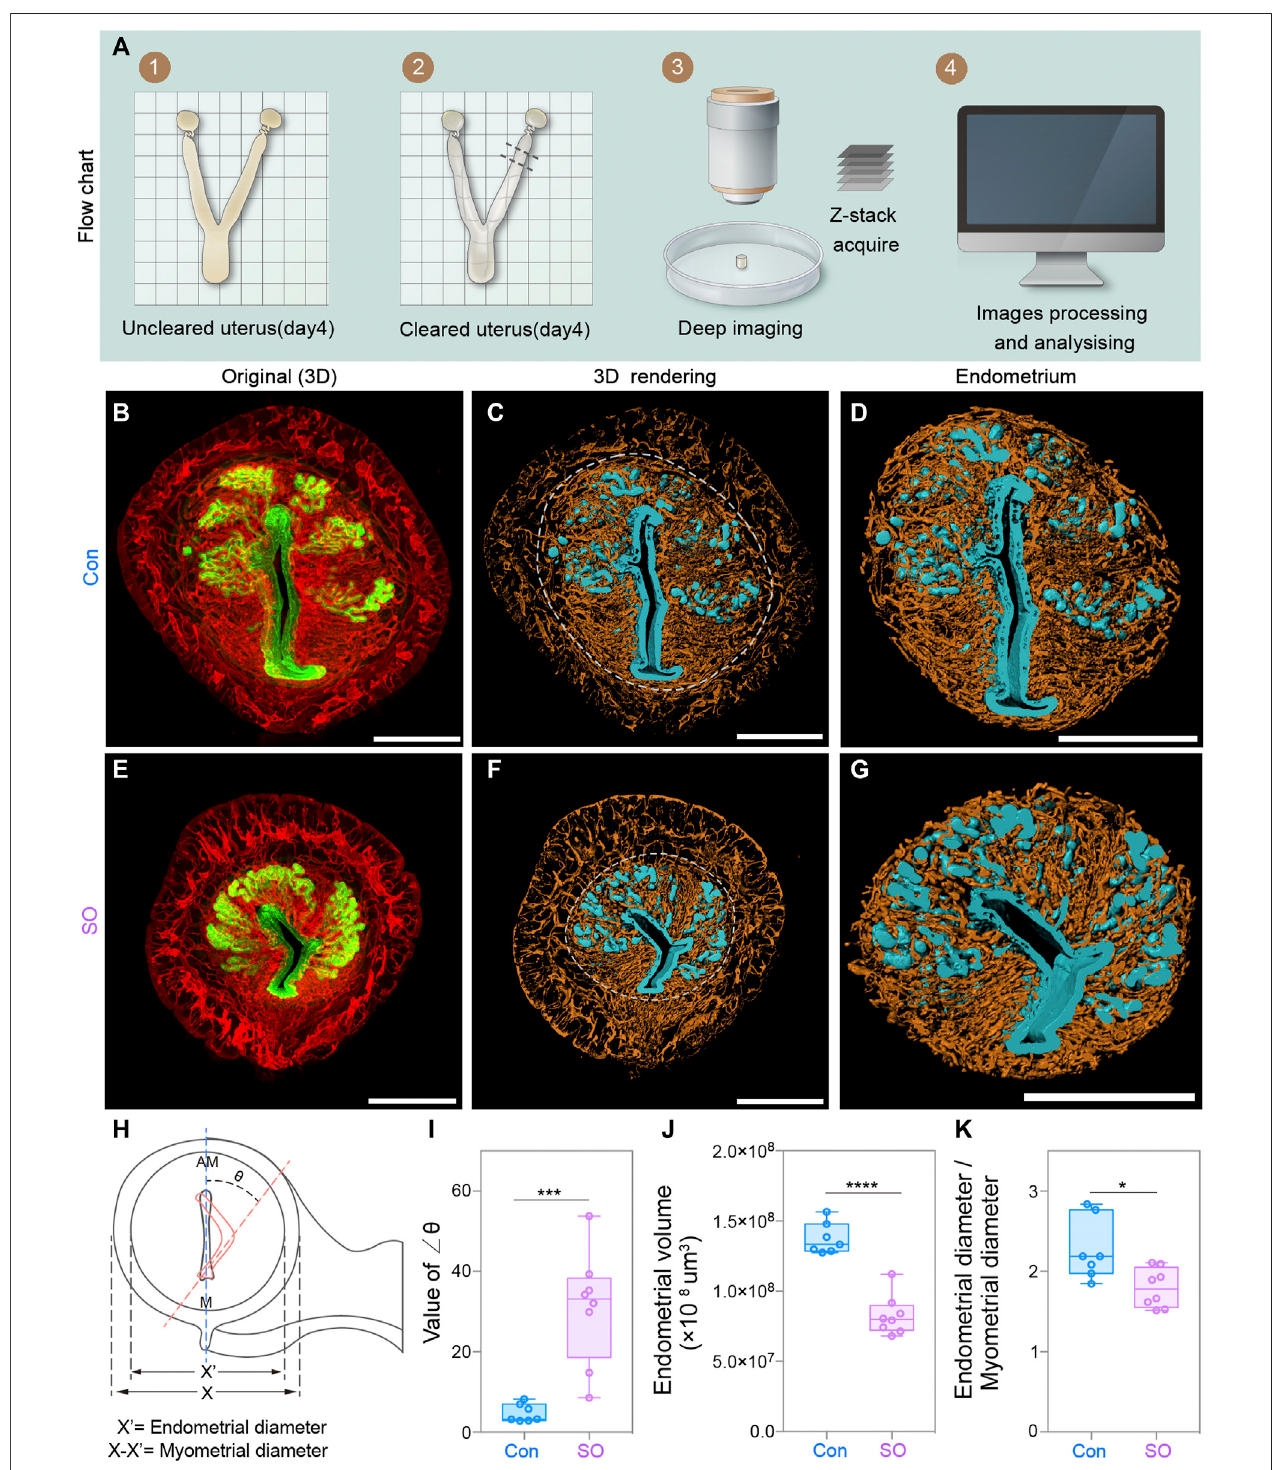
FIGURE 1 | Uterine endometrial changes in the 3D level after superovulation. (A) Experimental fl ow chart. (B) 3D reconstruction of the control uterus on day 4. (C – D) 3D rendering of the control uterus (C) and uterine endometrium (D) on day 4. (E) 3D reconstruction of the superovulation uterus on day 4. (F – G) 3D rendering of the superovulation uterus (F) and uterine endometrium (G) on day 4. (H) Schematic diagram illustrating the luminal orientation within the uterus and the diameter of the endometrium and myometrium. The normal luminal axis is parallel to the uterine M-AM axis in the control uteri, while the abnormal axis (delineated by the orange dashed line) is de fl ected from the uterine axis in the superovulation uteri. The angles of deviation are indicated as ∠ θ . (I) Comparing the value of the ∠ θ in the control and